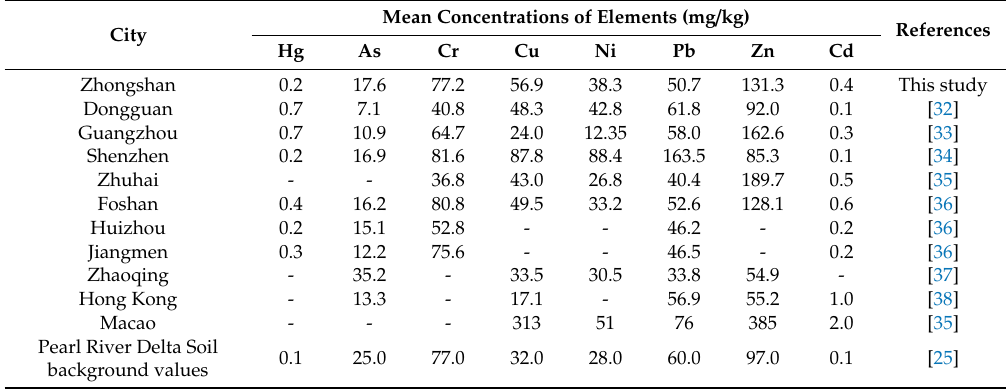
Table 5. Concentrations of eight elements in Zhongshan and other cities of the Guangdong–Hong Kong–Macao Greater Bay